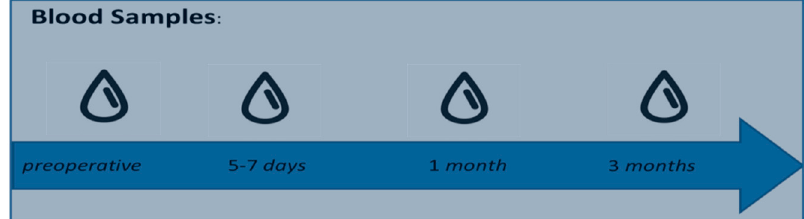
Figure 1. Period of time of blood